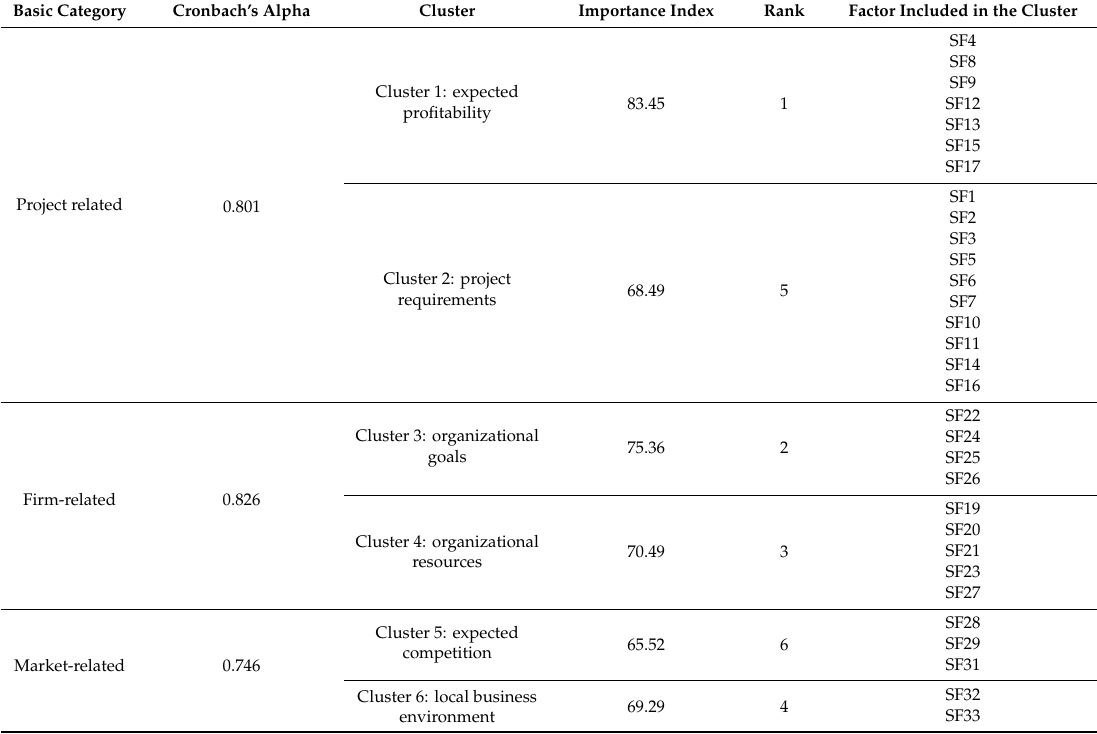
Table 4. Results of hierarchical cluster analysis (HCA) of the critical